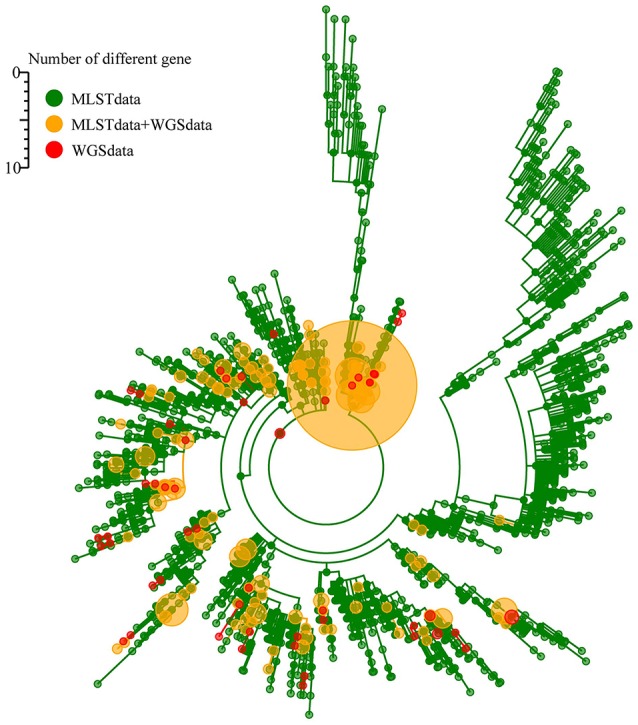
The representation of 671 genomes of K. pneumoniae population based on the K. pneumoniae MLST database.